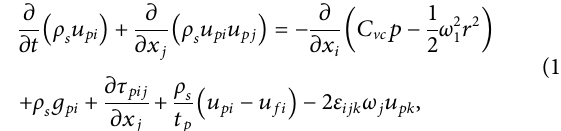
Frontiers in Energy Research |